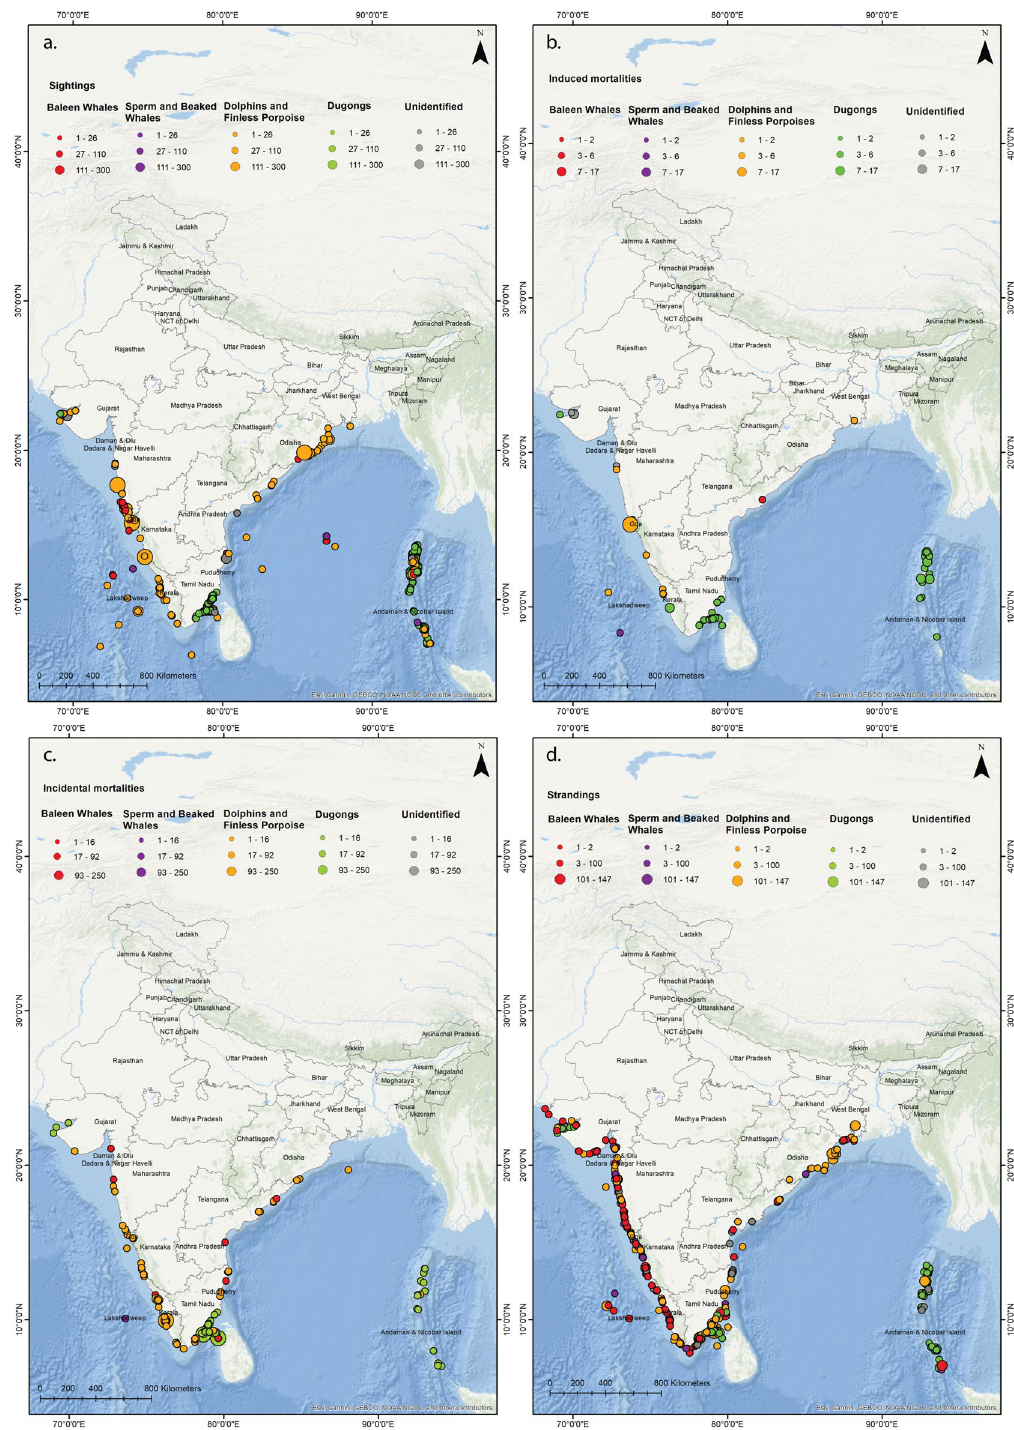
Figure 3. Bubble plots showing distribution of marine mammal records obtained from data compiled between years 1748–2017 along the Indian coastline for each group i.e., baleen whales (BW), dolphins and finless porpoise (DFP), sperm and beaked whales (SBW) and dugongs, as color-coded stacked bars, where ( a ) sighting—records where live animals were sighted ( b ) induced mortalities—records where animals were reported hunted or killed or were driven ashore, ( c ) incidental mortalities—records where animals were found dead after entanglement in fishing nets or being struck by vessels and ( d ) strandings—records where dead or live animals were found washed ashore, or floating near shore or stranded alive and were attempted for rescue. Size of the bubble indicates number of individuals. These maps were created using ArcGIS 10.5 (https:// deskt op. arcgis. com/ en/ arcmap/ 10.3/ map/ worki ng- with- layers/ about- symbo lizing- layers- to- repre sent- quant ity.